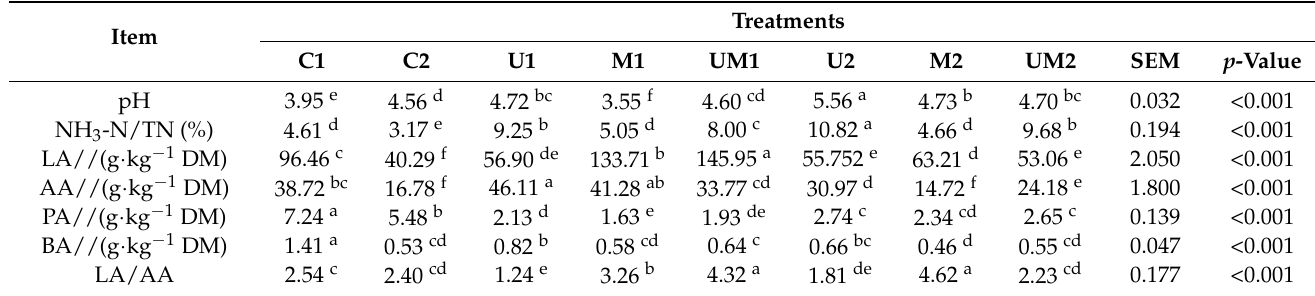
Table 9. Effect of additives on the fermentation quality of mixed